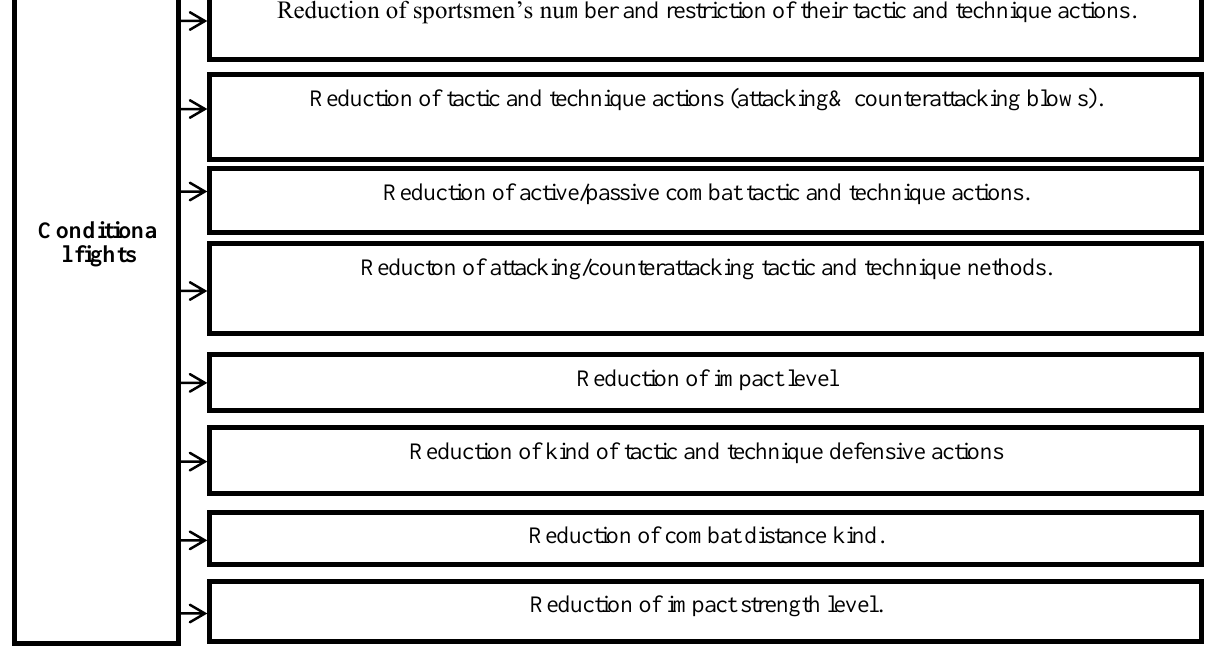
Fig.2. Alternative classification of conditional fights in